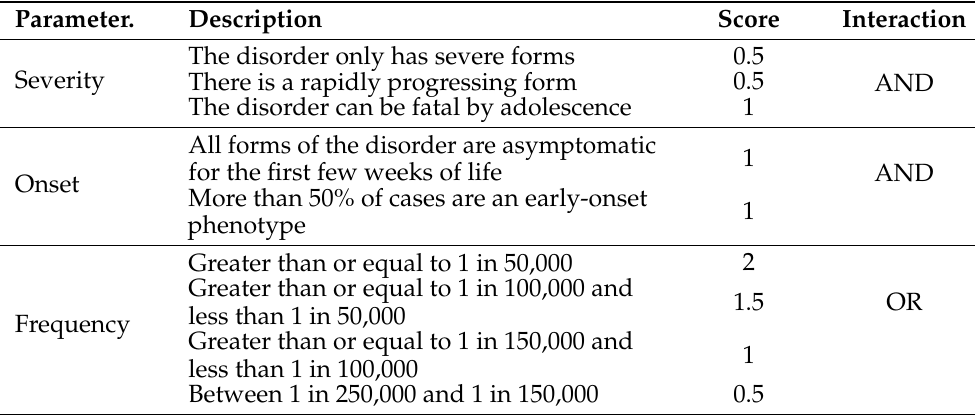
Table 3. Components of Pillar 1,